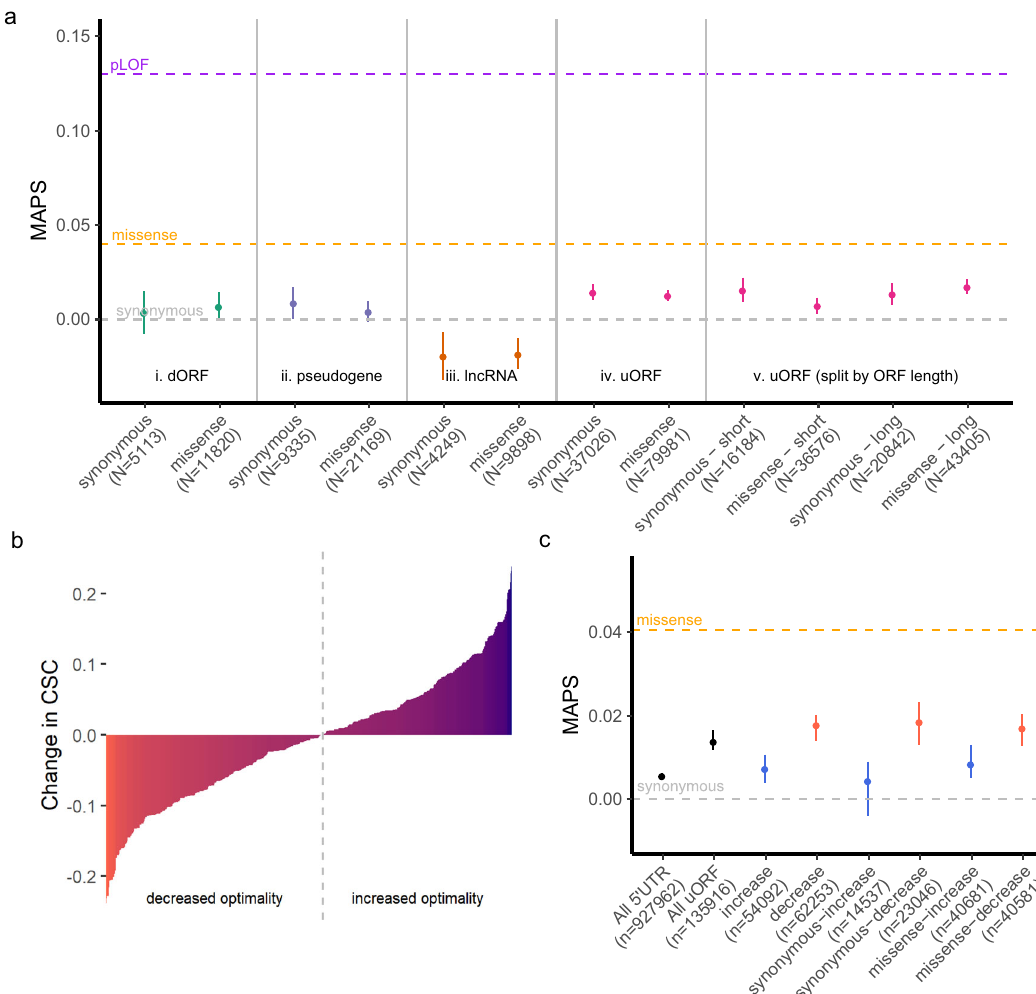
Fig. 2 uORFs do not exhibit strong selective pressure to maintain amino acid identity. a Points representing MAPS scores for single nucleotide variants within each ncORF category separated by predicted consequence (synonymous or missense) in each ORF. (i – iv) Allele frequencies for predicted missense SNVs are not signi fi cantly enriched for singletons than those for predicted synonymous SNVs. (v) MAPS scores are no different for long uORFs (>118 codons) compared to the rest (short). Gray, orange, and purple dashed lines represent MAPS scores for synonymous, missense, and predicted loss-of- function (pLOF) SNVs affecting canonical protein coding sequences in gnomAD. Error bars represent bootstrapped 90% con fi dence intervals. b Translated uORF variants ranked by predicted change to codon optimality using codon stability coef fi cient (CSC) scores from SLAM-seq (red = decreasing, blue = increasing) 34 . Gray dotted line denotes boundary separating optimality increasing versus decreasing SNVs. c Points representing MAPS scores for SNVs separated by predicted consequence on codon optimality shows heightened constraint against decreasing optimality variants, while variants increasing optimality are indistinguishable from all 5 ′ UTR variants. Error bars represent bootstrapped 90% con fi dence